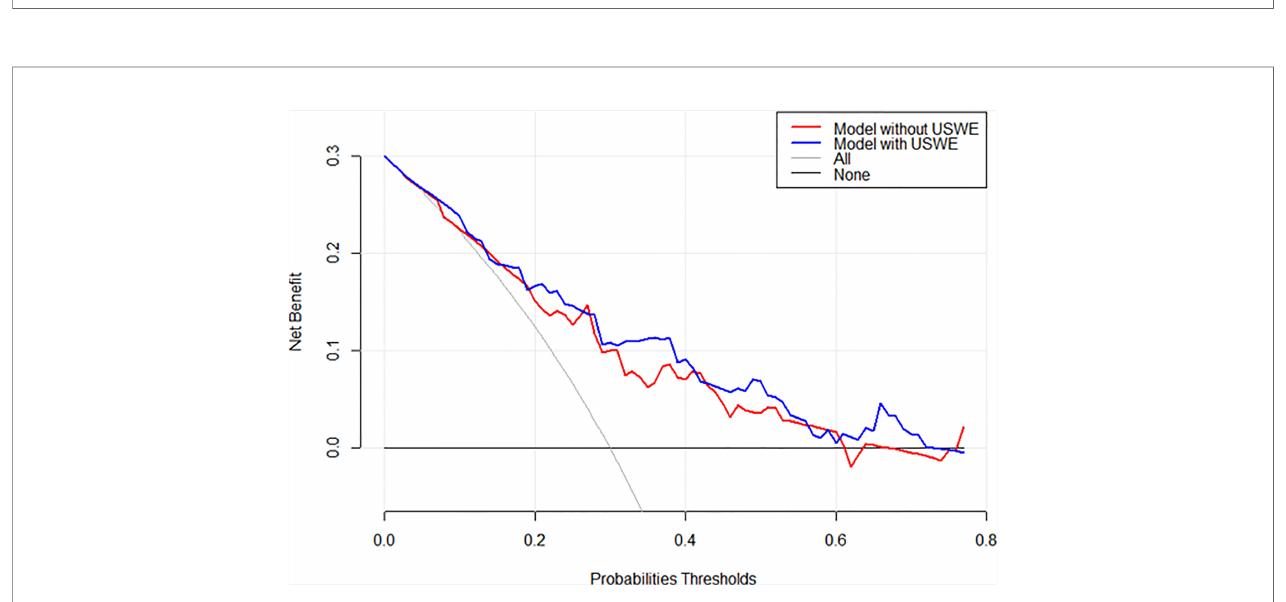
FIGURE 4 | Decision analysis demonstrated a high net bene fi t of USWE score model across a wide range of threshold probabilities. Prediction model without USWE score (red line); prediction model with USWE score (blue line).